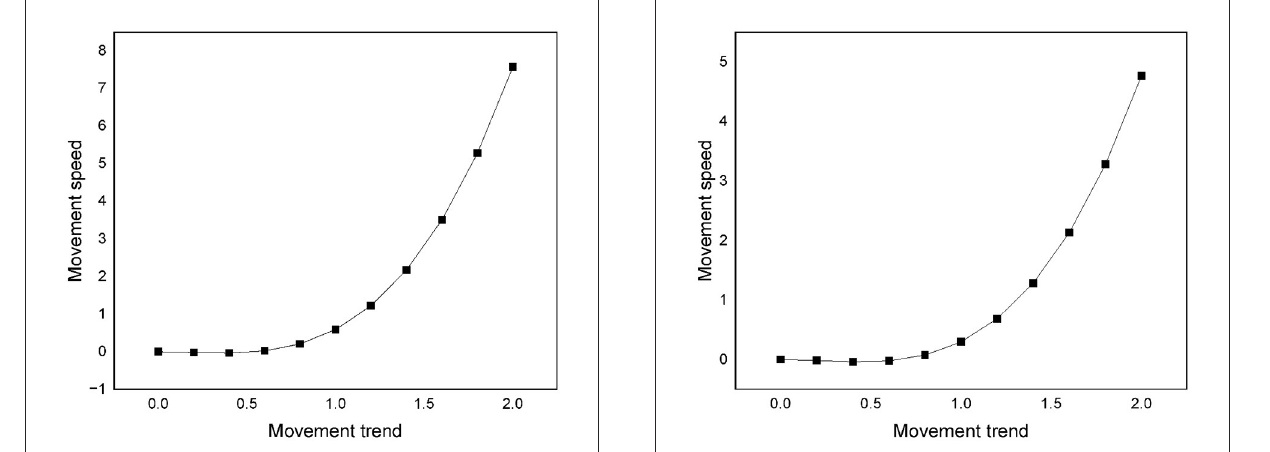
FIGURE2 The potential function simulation of environmental system.